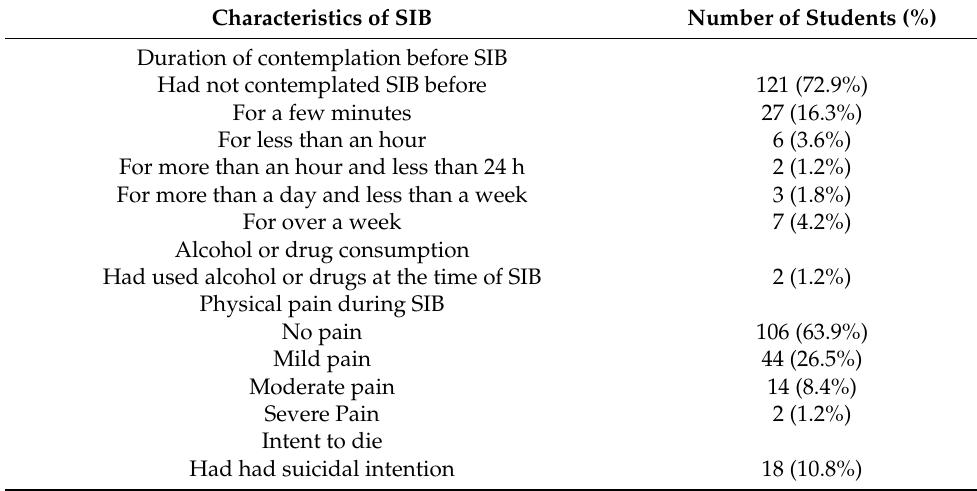
Table 3. Characteristics of self-injurious behaviors.